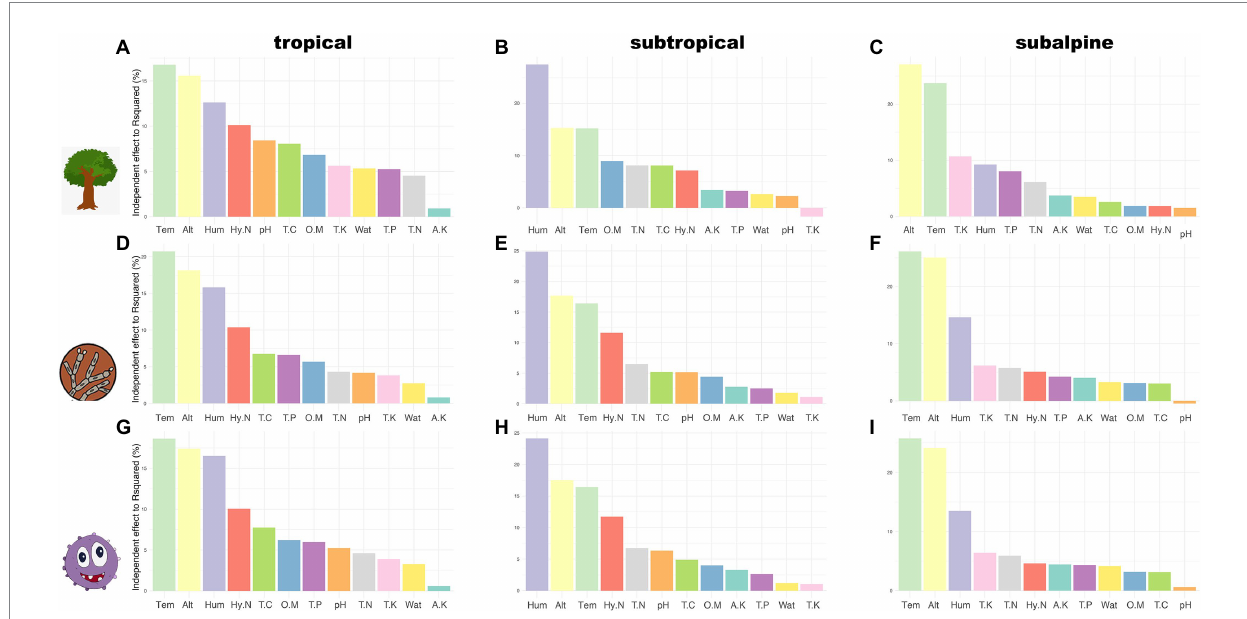
FIGURE 4 The explanatory power of soil factors for species composition in three climatic zones. A - C : tree species; D - F : fungal species; G - I : bacterial species. OM: organic matter; TC: total carbon; TN: total nitrogen; HN: hydrolysable nitrogen; TP: total phosphorus; TK: total potassium; AK: available potassium; pH: soil pH; Wat: soil moisture content; Alt: altitude/elevation; Tem: air temperature; Hum: air